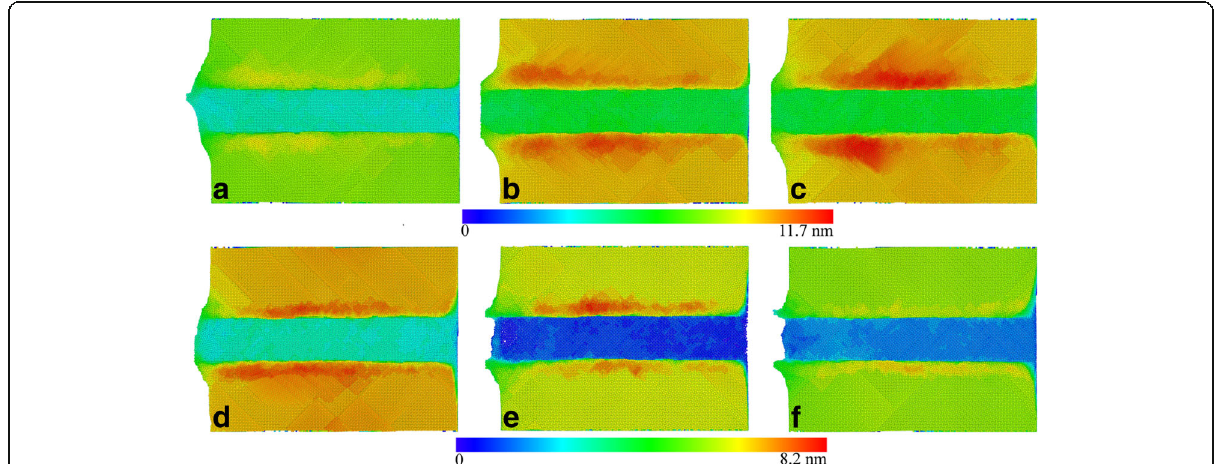
Fig. 8 Rake angle dependence of machined surface morphologies; (color online) machined surface morphology with different rake angles: a − 10°,